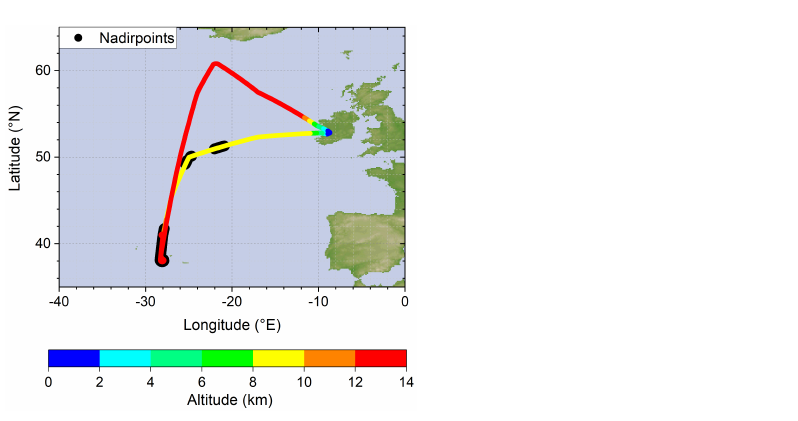
Figure 5. Flight track of WISE campaign flight F06 on 27 September 2017, colour coded for aircraft GPS altitude as indicated by the legend. Black dots indicate time slots where GLORIA was operated in the nadir viewing